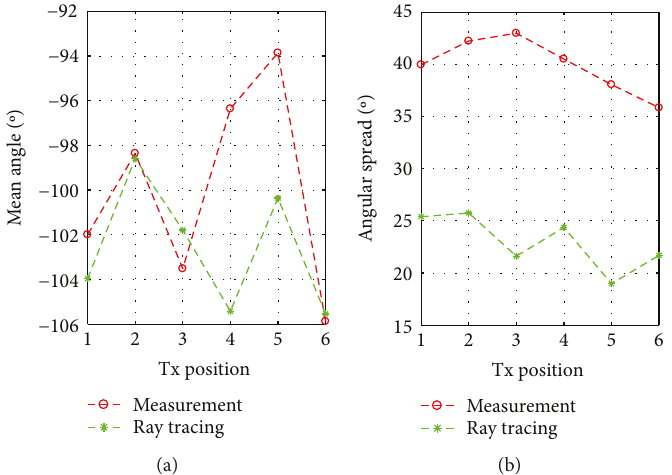
Figure 21: Measured and RT-simulated mean angles (a) and angle spread (b) for all Tx positions in the o ffi ce LOS